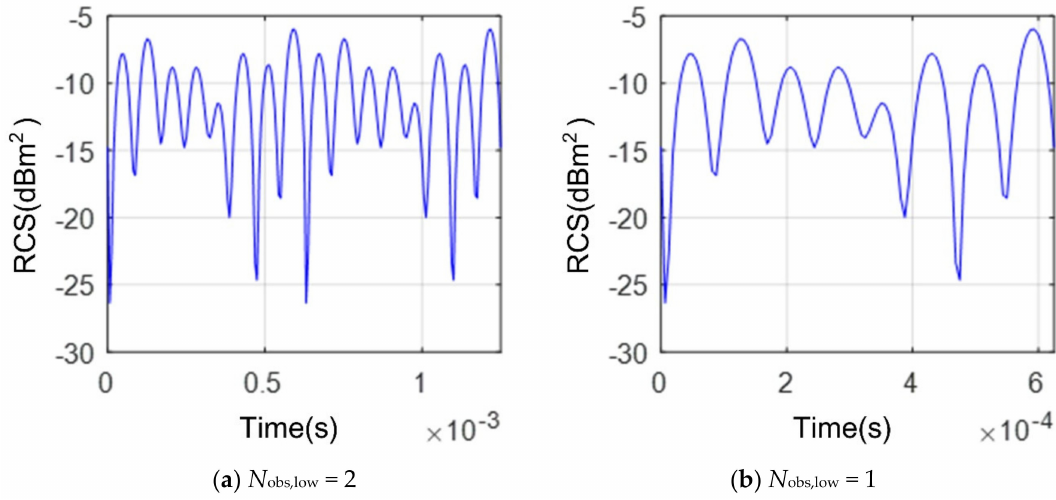
Figure 8. Influence of observation time on dynamic radar cross-section (RCS) of m low , α = 160 ◦ and β = 0 ◦